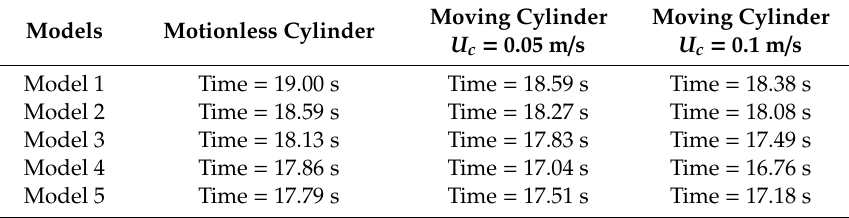
Figure 23. The time variation of the hydrodynamic forces for model 5. ( a ) The comparison between the unmoved cylinder (red line) and the moving cylinder at U c = 0.05 m/s. ( b ) The comparison between the unmoved cylinder (red line) and the moving cylinder at U c = 0.1 m/s. Table 5. Time occurrences of the peaks of the vertical forces.